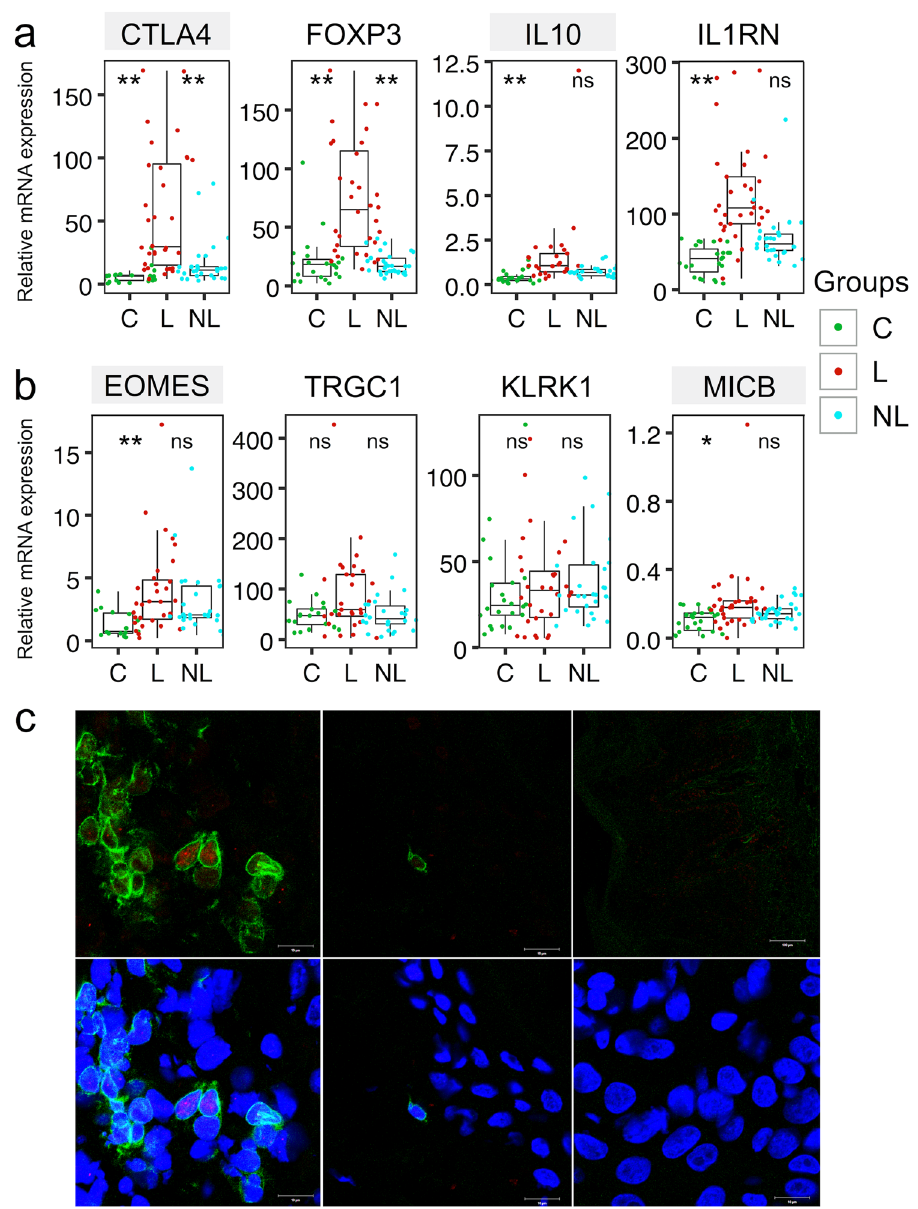
Figure 2. Several immunoregulatory genes and marker transcription factors are upregulated in psoriatic skin. mRNA expression of several immunoregulatory genes ( a ) and genes specific for different cytotoxic effector cells ( b ) relative to ACTB in skin biopsy samples obtained from lesional (L) and non-lesional (NL) skin of psoriasis patients and from age-matched control individuals (C). The description of the box-and-whiskers and stars can be found in the legend of Fig. 1. Gray shading behind the gene name indicates statistically significant differences between NL and C samples ( P < 0.001). ( c ) Fluorescence microscopic images illustrate CD3 expression (green) and Eomesodermin staining (red) in psoriatic lesional skin biopsy frozen sections (left). The middle panels represent healthy control skin and right-hand panels negative control staining (secondary antibodies only). The lower panels include 4 ′ ,6-diamidine-2 ′ -phenylindole dihydrochloride (DAPI) for counterstaining cell nuclei. White bar represents 10 µ